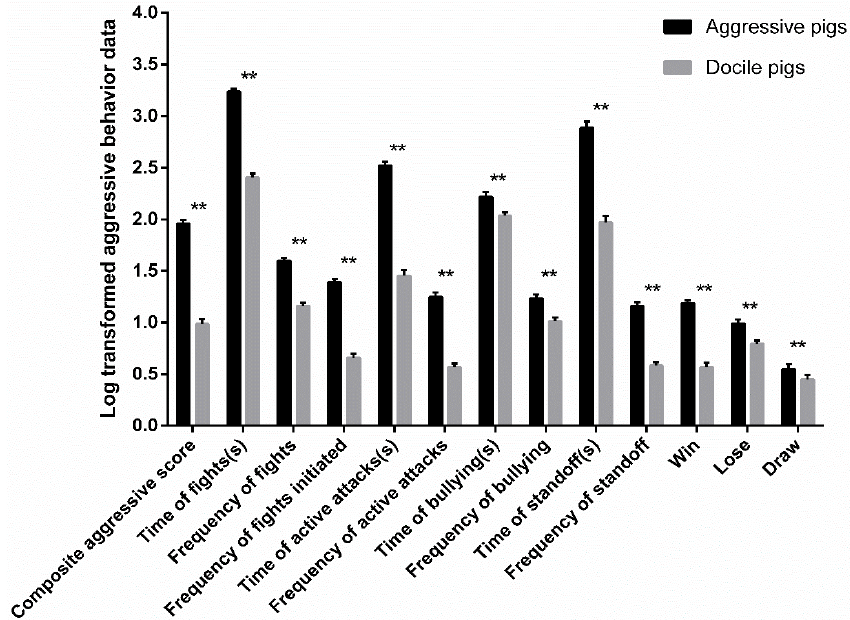
Figure 1. The log transformed aggressive behavioral indicators within 36 h after mixing between aggressive pigs (n = 102) and docile pigs (n = 102). ** p < 0.01.